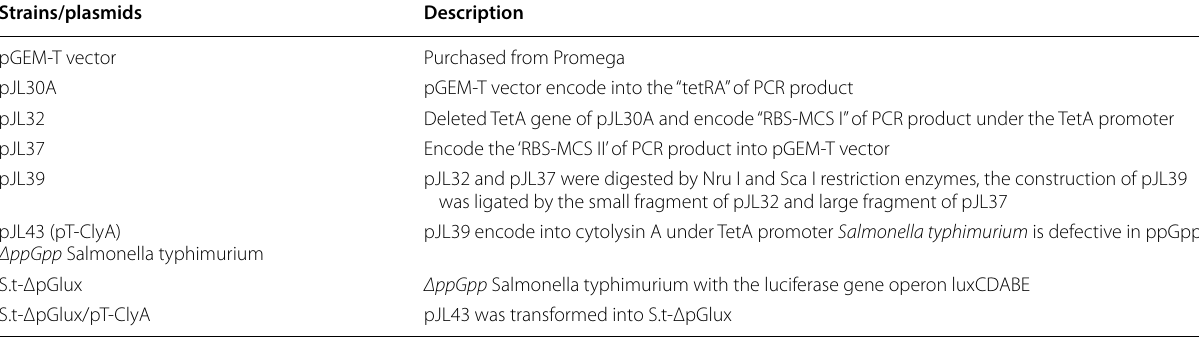
Table 2 Plasmids and Salmonella typhimurium strains used in this study